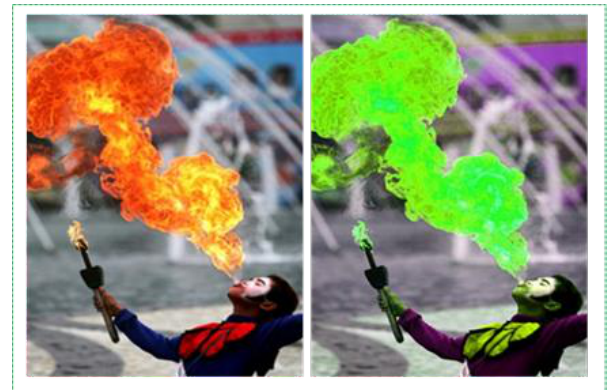
Figure 6. Fire images before and after hue augmentation.